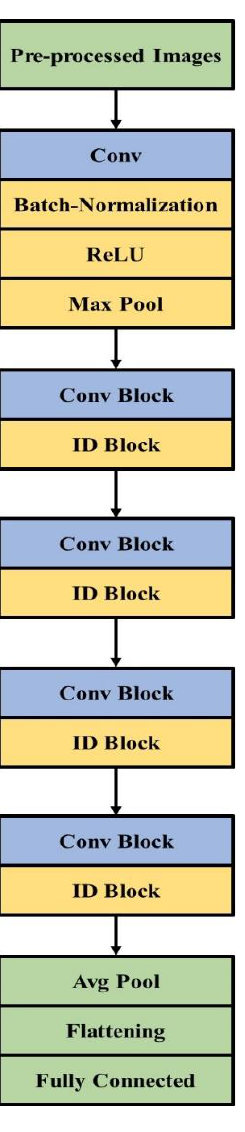
Figure 5. ResNet50 model for feature extraction.